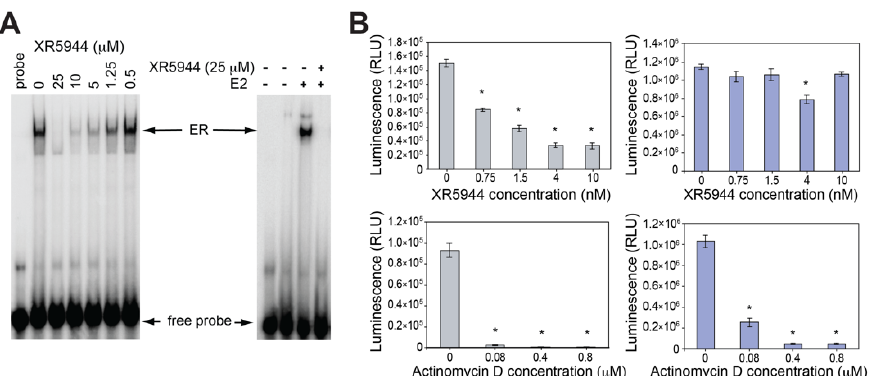
Figure 5. ( A ) Electrophoretic mobility shift assays (EMSA) showing that XR5944 inhibits the ER binding to consensus ERE DNA probe using ER extracted from MCF-7 nucleus (left) and recombinant ER α in the presence of estrogen (right). ( B ) XR5944 decreases the ERE-promoted transcription (left) but not the pGL3-promoted transcription (right) in luciferase reporter assay. The general transcription inhibitor actinomycin D decreases both transcriptions (bottom). Columns , mean of three independent experiments; bars , standard error; * p < 0.01, statistically significant difference. Modified from Punchihewa, C.; De Alba, A.; Sidell, N.; Yang, D. XR5944: A Potent Inhibitor of Estrogen